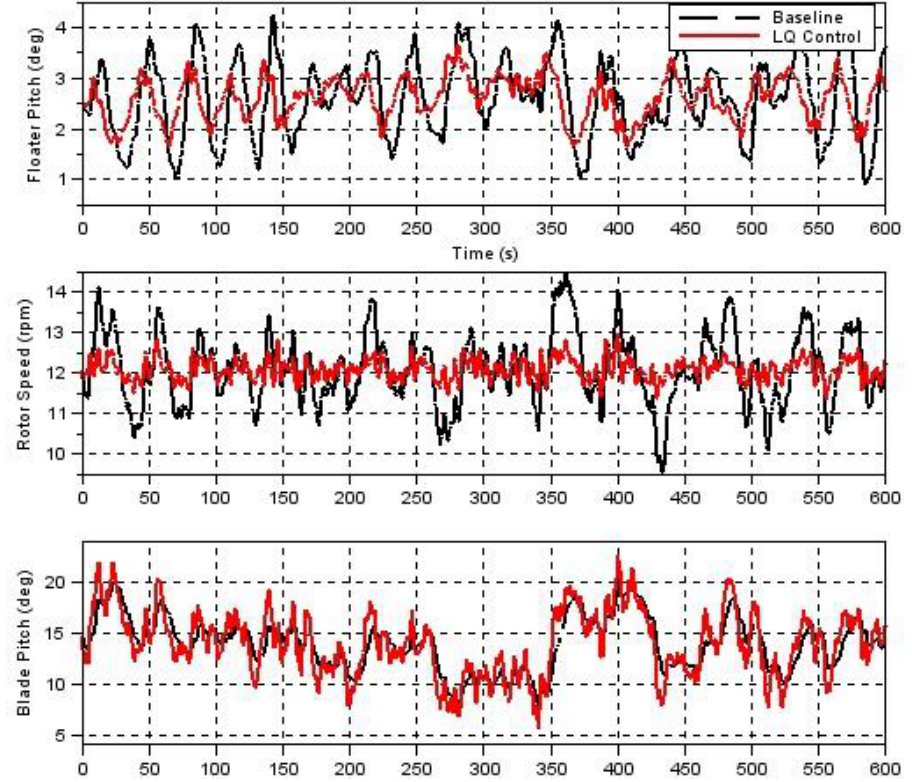
Figure 4. LQ control of a spar FOWT—moderate sea state.